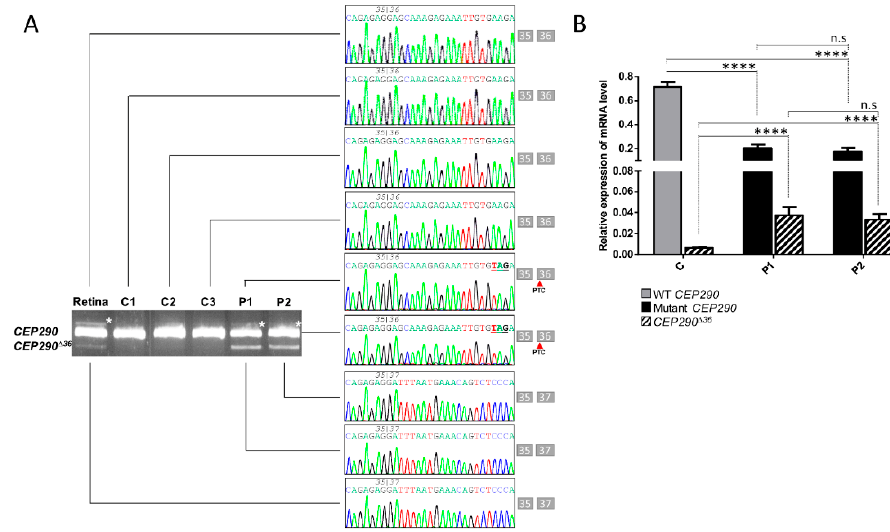
Figure 1. Naturally occurring exclusion of CEP290 exon 36 encompassing premature stop codon. ( A ) Analysis of CEP290 transcript extracted from wild-type human fetal retina (Retina), control